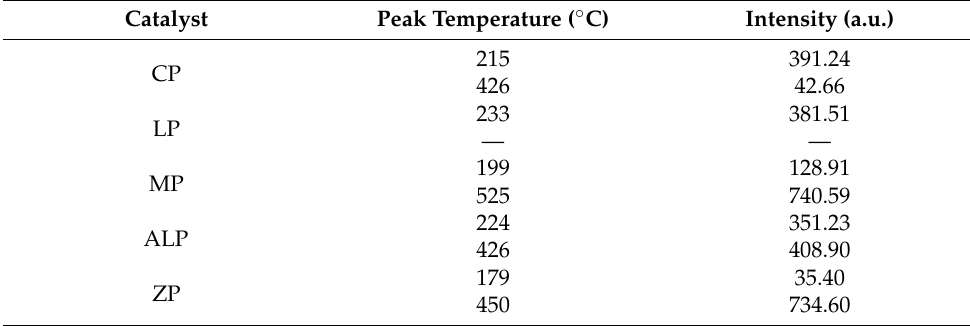
Figure 5. NH 3 -TPD curves of different metal phosphate catalysts. Table 2. Textural properties of different metal phosphate